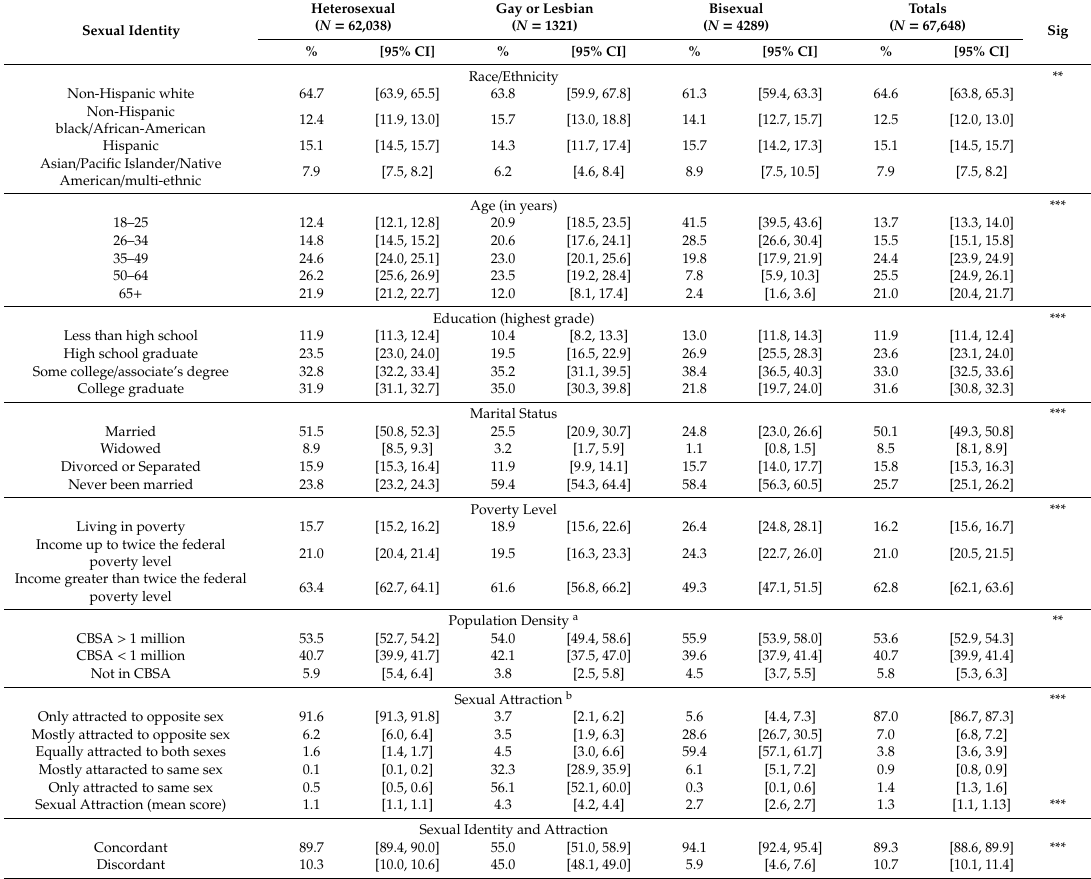
Table 1. Demographics and Self-reported Sexual Attraction by Sexual